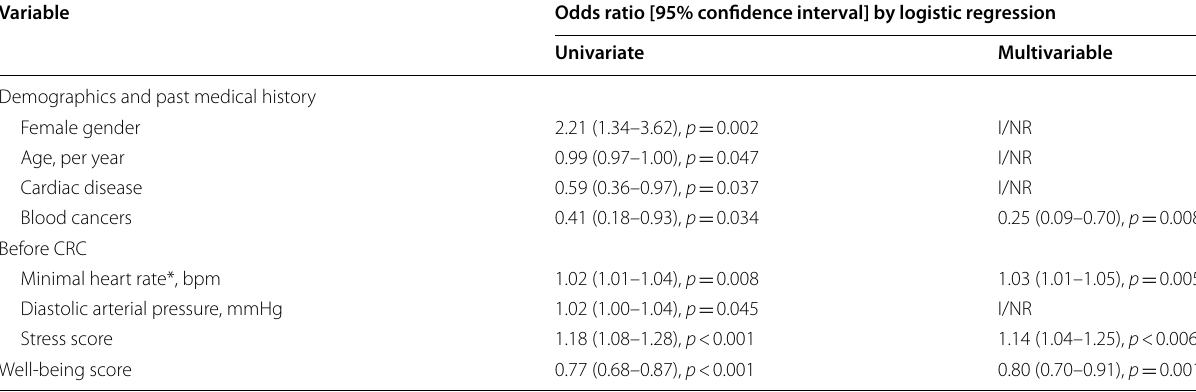
* Measured in the preceding 24 h; I/NR, included, but not retained in the final model; the multivariable model showed a good calibration as assessed by Hosmer and Lemeshow goodness‑of‑fit test [ χ 2 (4 df ) 5.31, p 0.72] and a fair discrimination as assessed by the receiver operating characteristics curve [area under the curve of = = 0.76 (0.70–0.83), p < 0.0001]